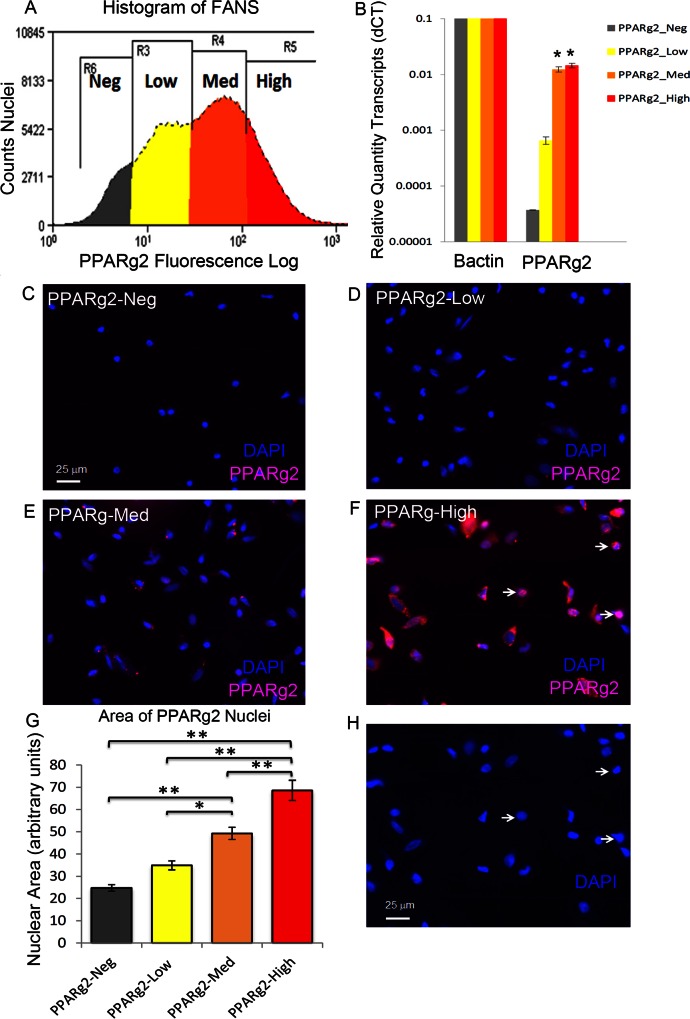
Fluorescence activated nuclear sorting (FANS) of three classes of visceral adipose tissue cellular nuclei immuno-stained for PPARg2.A. Histogram of PPARg2-Neg, -Low, -Med. and -High stained nuclei from sorting experiment (log scale) gated for DNA content (DAPI subset, S1B Fig) and forward and side light scattering (S1A Fig). B. PPARg2 transcript levels were assayed among the four fractions of nuclei by qRT-PCR. C, D, E, F. Merged immunofluorescence microscope images of four isolated fractions of nuclei without re-staining. G. Comparison of the average nuclear area for the four fractions from one experiment (N = 100). There were statistically significant differences between all of the fractions of nuclear areas except for between PPARg2-Low and PPARg2-Neg fractions. H. PPARg2-High nuclei from image H showing the DAPI staining alone to reveal decondensed nuclei, however, some strongly stained PPARg2-High nuclei are small reflecting some heterogeneity in their morphology, as indicated by white arrows. For antibodies see S1 Table. A p value of P<0.01 is denoted by an asterisk (*) and a p value of P<0.001 is denoted by a double asterisk (**).